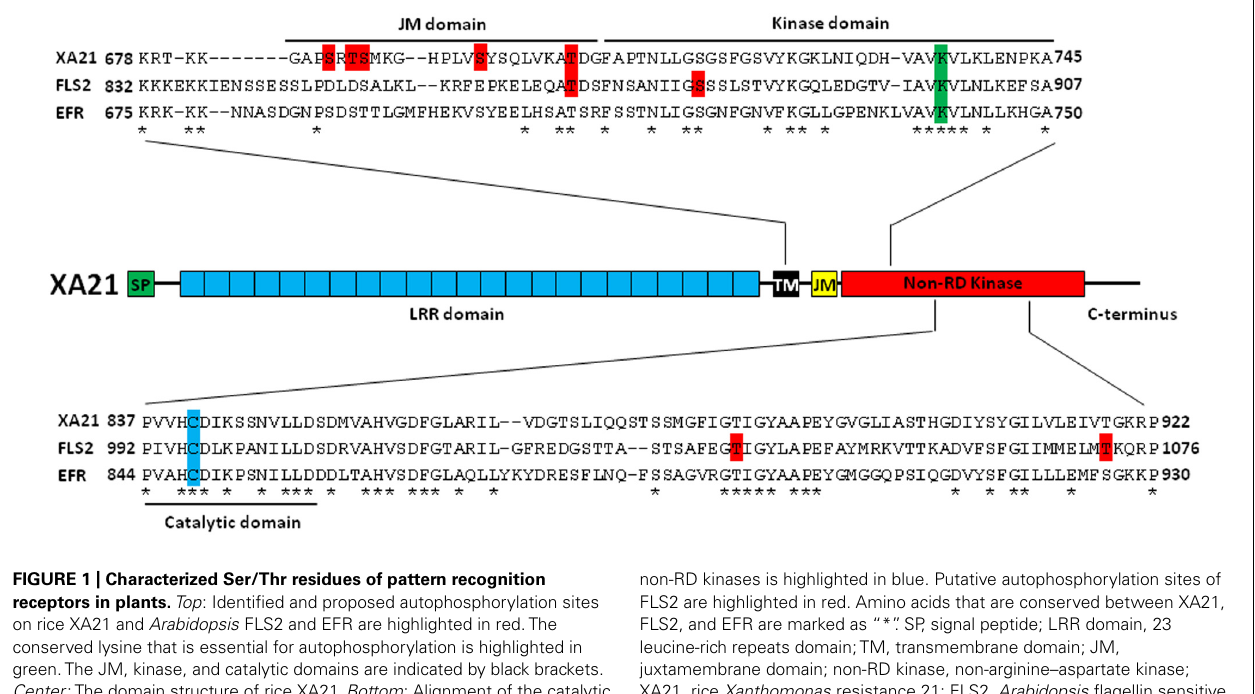
FIGURE 1 | Characterized Ser/Thr residues of pattern recognition receptors in plants. Top : Identified and proposed autophosphorylation sites on rice XA21 and Arabidopsis FLS2 and EFR are highlighted in red.The conserved lysine that is essential for autophosphorylation is highlighted in green.The JM, kinase, and catalytic domains are indicated by black brackets. Center :The domain structure of rice XA21. Bottom : Alignment of the catalytic domains of XA21, FLS2, and EFR.The cysteine that replaces the R in these